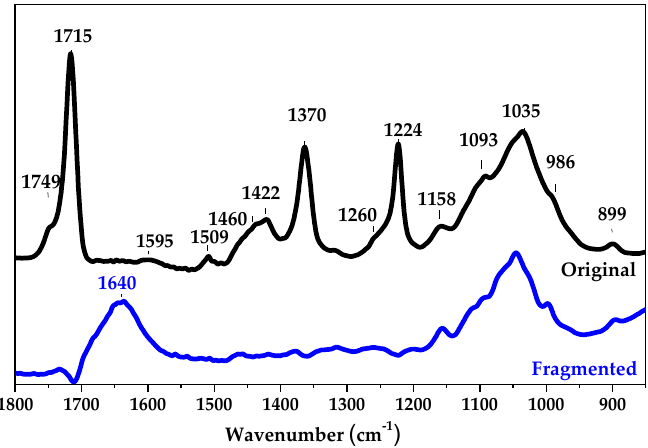
Figure 8. FTIR absorption spectra of the original wheat straw and the solid fraction (rich in sugars) obtained after pretreatment with [EMIM]OAc.